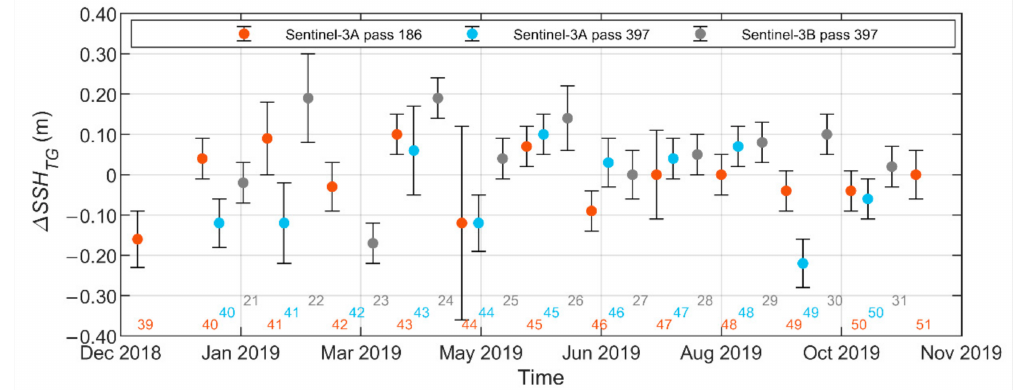
Figure 8. Residual di ff erences ( ∆ SSH TG ) between the sea surface height of Sentinel-3 ( SSH SA ) and the geoid-based sea surface height ( SSH TG ) in the Gulf of Riga. The zero line denotes the reference SSH TG . Colored numbers indicate the corresponding cycle number for each satellite. Vertical bars represent the ± 1 σ standard